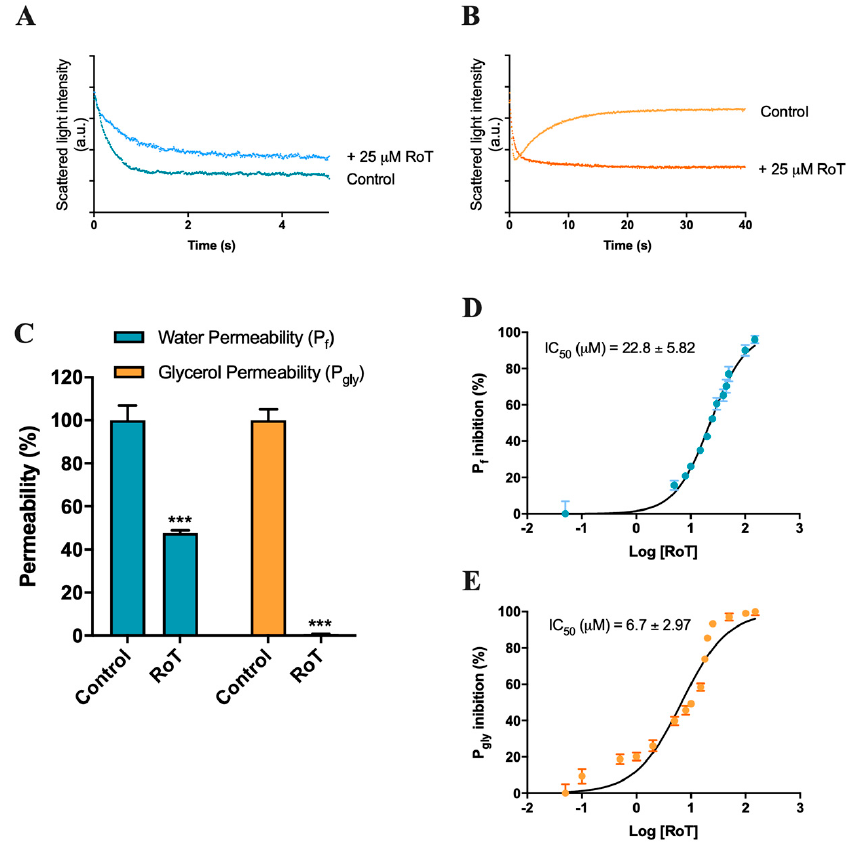
Figure 2. Effect of RoT on hRBCs membrane permeability. ( A ) Representative stopped-flow signal of cells confronted with a hyperosmotic sucrose solution. Cells shrink due to water efflux (control). Cell treatment with RoT decreases water efflux rate. ( B ) Representative stopped-flow signal of cells are confronted with a hyperosmotic glycerol solution. After a first cell shrinkage due to water efflux, glycerol enters the cell via AQP3, resulting in water influx and cell reswelling (control). Cell treatment with RoT prevents glycerol influx. ( C ) Water and glycerol permeability of cells incubated with RoT (25 µM for 30 min). ( D ) Dose-response curve of water permeability inhibition by RoT. ( E ) Dose-response curve of glycerol permeability inhibition by RoT. Data are shown as mean ± SD of three independent experiments. *** p < 0.001, treated vs. non-treated